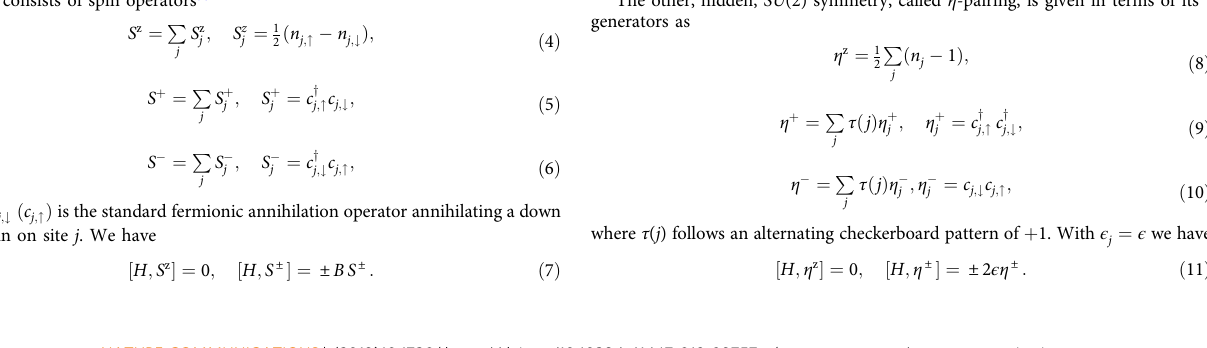
Fig. 3 Time evolution of spin observables in both the open and closed Hubbard model during a quench. a Dynamics of S x system following a quench (the inset shows relaxation and the fi rst revival of the fi nite-size closed system). The initial state is the Hubbard model ground ffiffiffi p τ , B = 0 and no disorder. At time t = 0 the system is quenched to U = τ , B = 0.8 τ and disorder state with N = 5 particles, M = 7 sites, U ¼ 2 (cid:5) (cid:4) (cid:8)(cid:5) (cid:5) (cid:5) starting from a high-temperature thermal state / ε 2 ½ 0 : 0 ; 0 : 16 (cid:3) τ . b Dynamics of S þ ð t Þ S (cid:2) ð t Þ j n 1 fermions in M = 5 sites. The magnetic fi eld initially points either along the x -direction (blue lines) or the z -direction (green lines). At time t = 0 dephasing ffiffiffi p γ ¼ 0 : 4 τ is switched on and B pointed along the z -direction. Long-range correlations emerge from the initially thermal state through dephasing. The inset (cid:4) (cid:8)(cid:4) (cid:8) shows S x i ð t Þ and the magenta dashed lines represent analytical values in the long-time